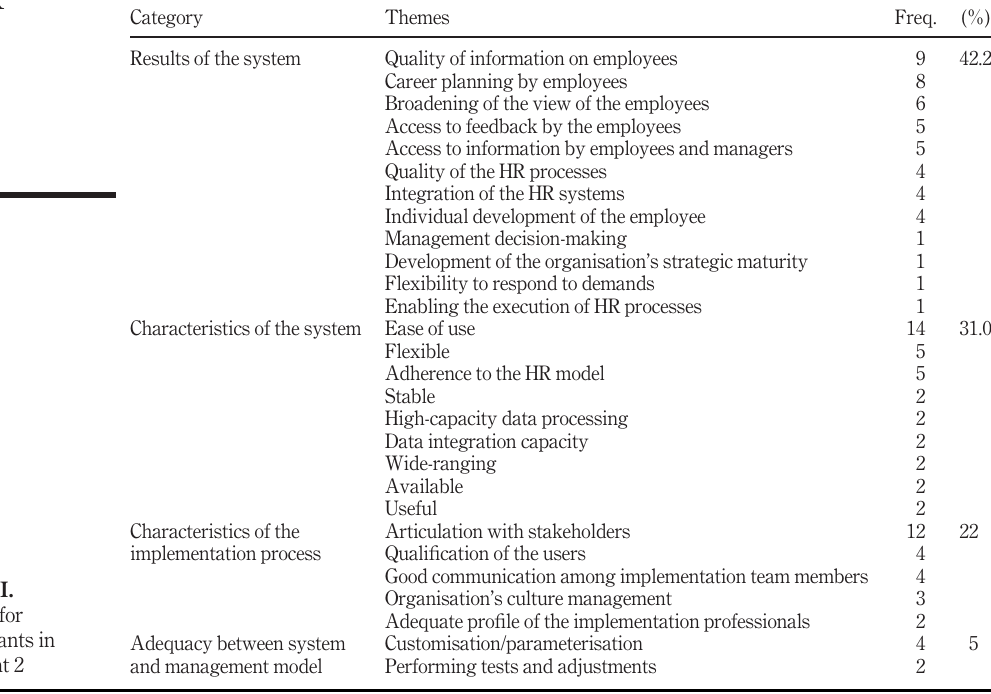
Table II. Results for participants in quadrant 2